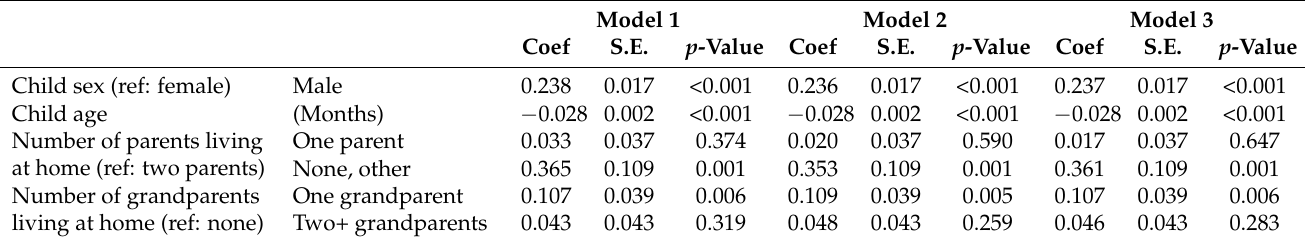
Table 3. Relationship between multiple types of poverty and children’s behavioral outcomes (SDQ total